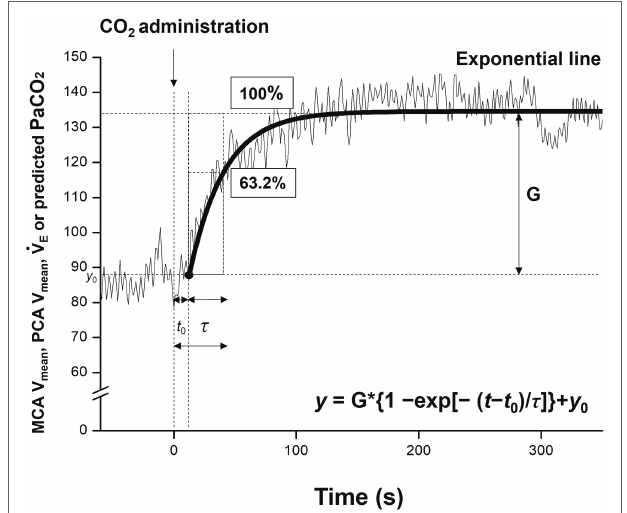
FIGURE 1 | Single-exponential regression model, t 0 ; the response time latency from induction of carbon dioxide administration to change [CO 2 - response delay], y 0 , baseline value; and G, gain term, and τ ; time constant of the fitted curve of exponential regression during CO 2 administration. Time